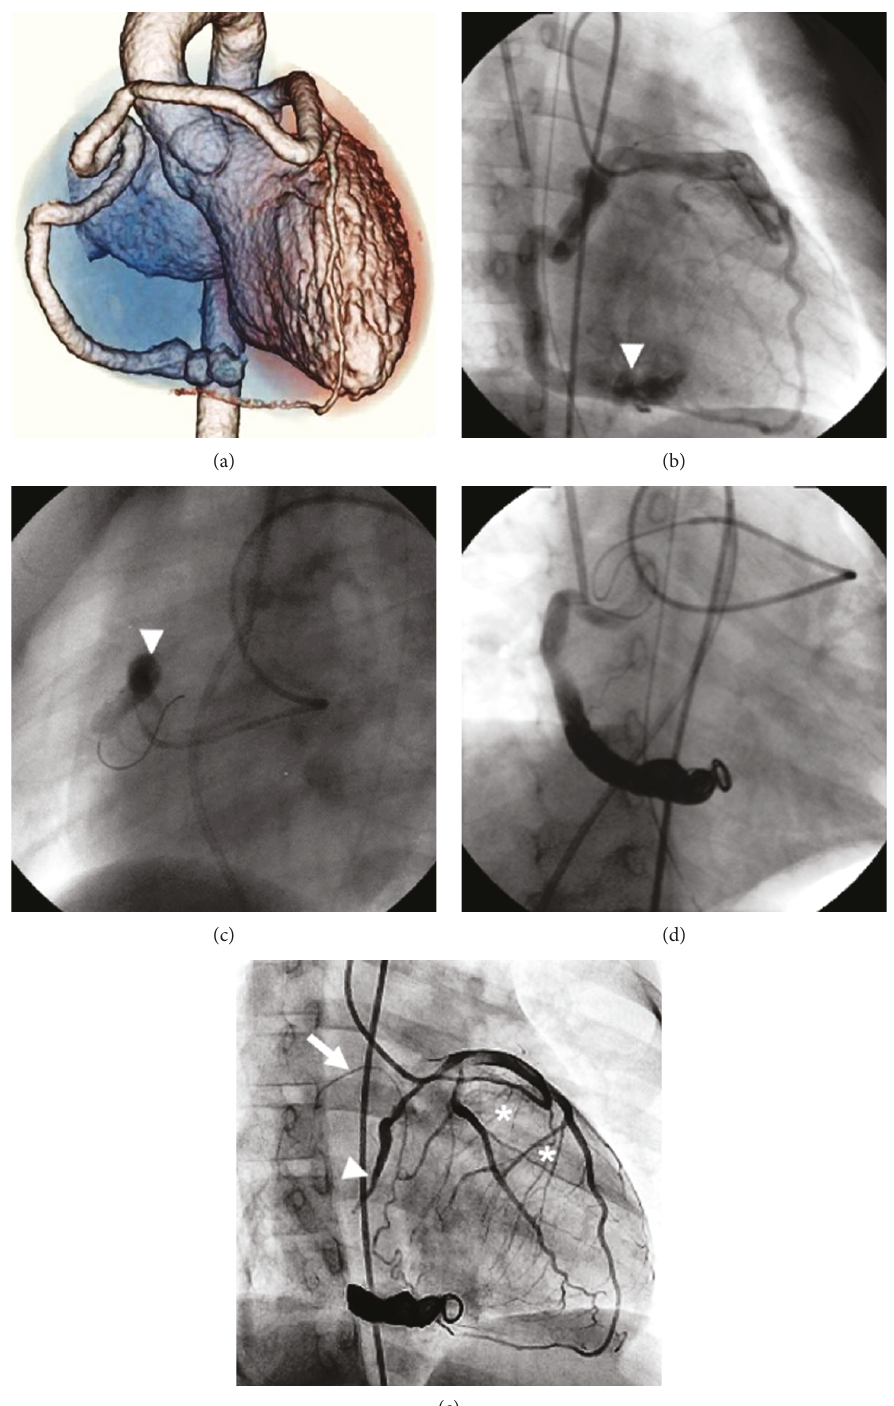
Figure 1: (a) 320-row coronary CTA. The single coronary artery view shows the anterior course of the separate right coronary artery coming o ff the LAD. This is the anterior view. (b) Selective coronary angiography of the LMT shows the LAD and the LCX with weak contrast e ff ects and a CAF with “ multiple caliber change ” of the RCA to the right ventricle (arrowhead). (c) Occlusion test on the proximal site of CAF using an occlusion balloon (arrowhead). (d) Engaged microcatheter in the distal RCA and embolization using a detachable coil. (e) One year after coil embolization, selective LMT coronary angiography clearly distinguishes the contrast e ff ect of the LAD and LCX, the sinus node branch branching from LCX (white arrow), and right ventricular branches from the proximal side of the RCA (asterisks). The proximal end of the coil-embolized CAF formed a thrombus and occluded (arrowhead). CAF: coronary artery fi stula; CTA: computed tomography angiography; LAD: left anterior descending coronary artery; LCX: left circum fl ex coronary artery; LMT: left main coronary trunk artery; RCA: right coronary